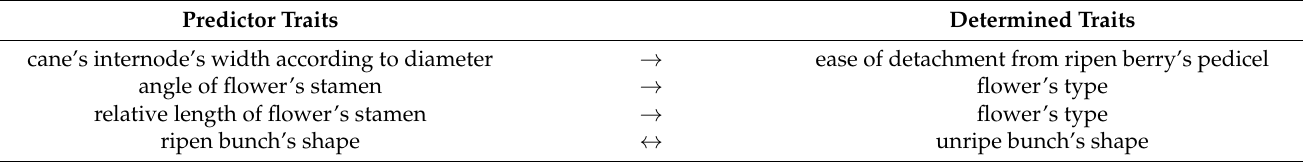
Table 4. Traits that are fully determined by another trait together with the direction of determination. Predictor Traits Determined